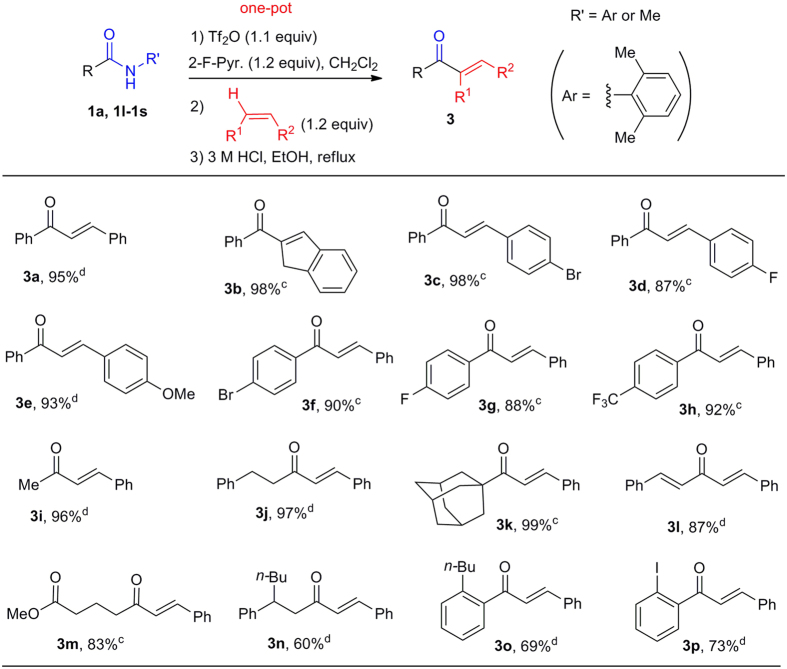
Metal-free direct coupling of benzamide derivatives with alkenes to give enones 3.aReaction conditions: Amide (1.0 equiv), 2-F-Pyr. (1.2 equiv), CH2Cl2 (0.25 M), then 0 °C, Tf2O (1.1 equiv), 10 min. Alkene (1.2 equiv), 2 h. EtOH and 3 M HCl, reflux. bIsolated yield. cReaction ran at room temperature (rt). dReaction ran at 40 °C.